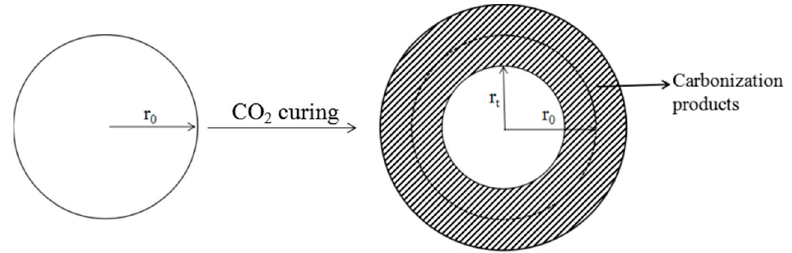
Figure 3. Schematic of the particles in compacts before and after CO 2 curing.